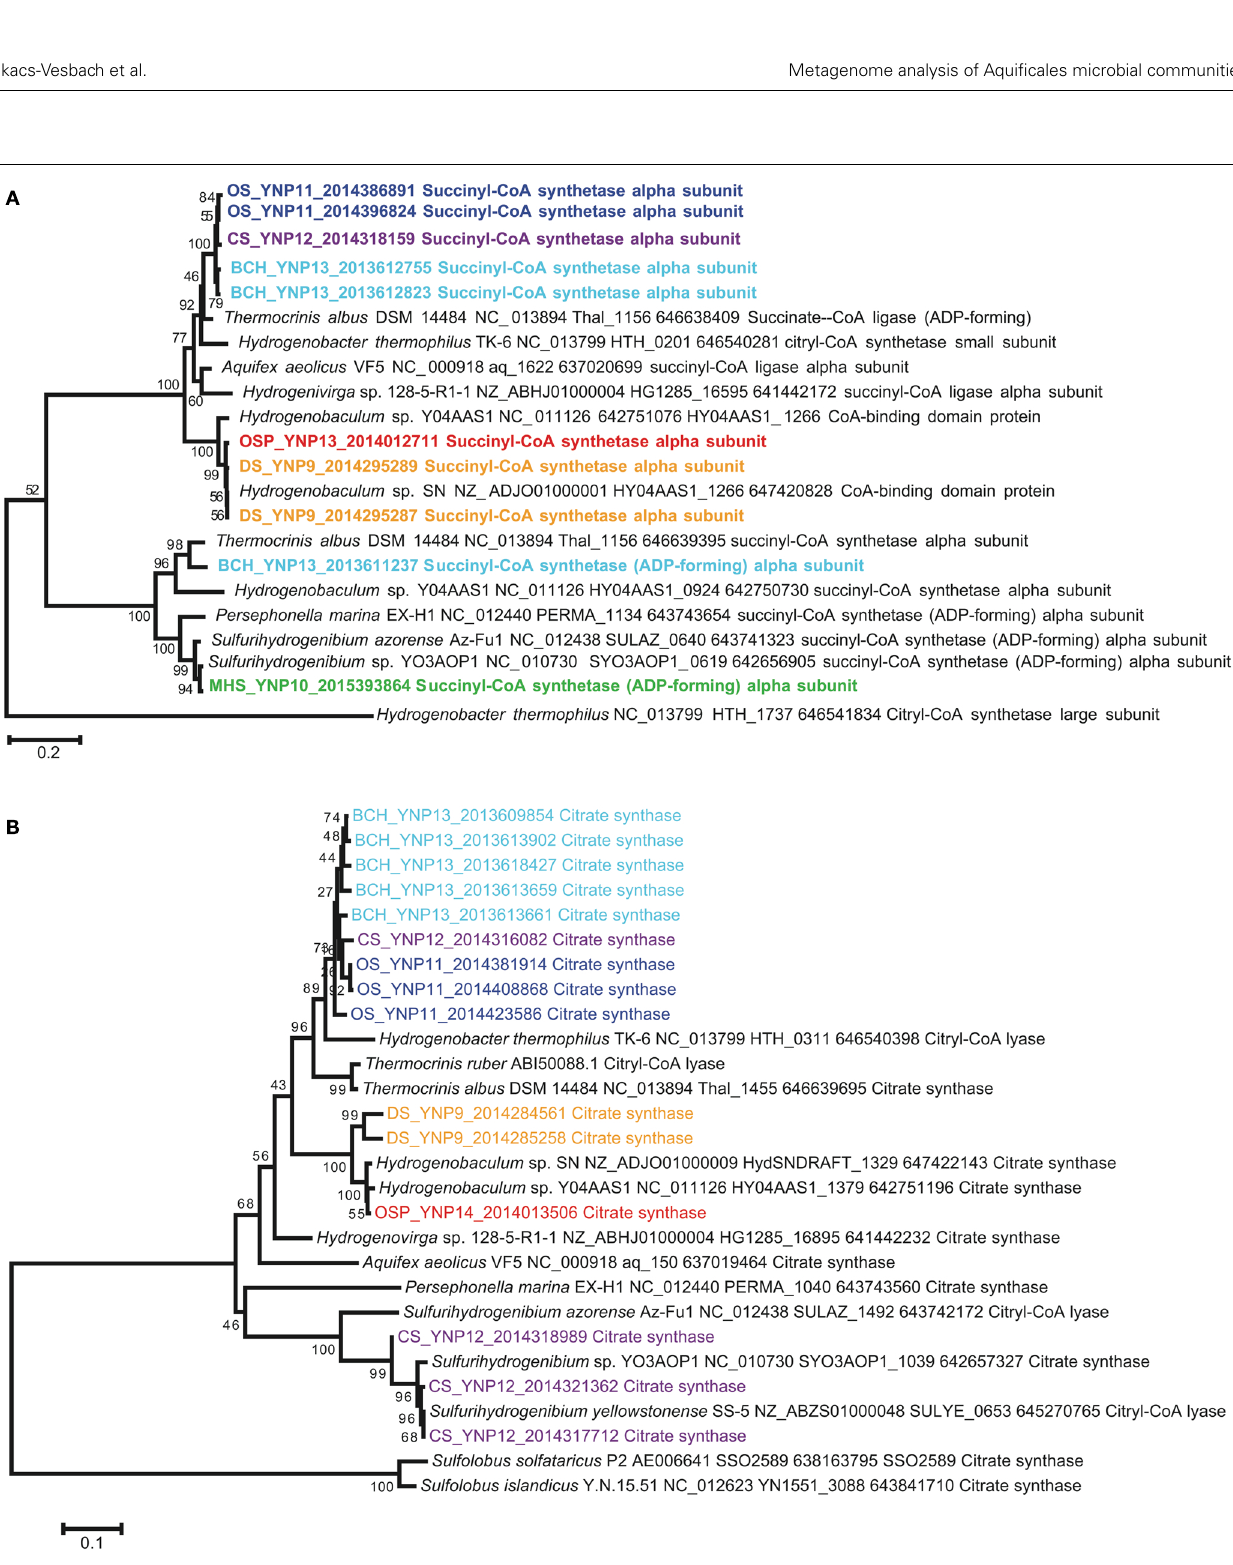
The oxidation of arsenite to arsenate is highly exergonic (rang- ing from 50 to 60 kJ/mol electron) in these geothermal systems (Inskeep et al.,2005) and has been shown to serve as a sole electron